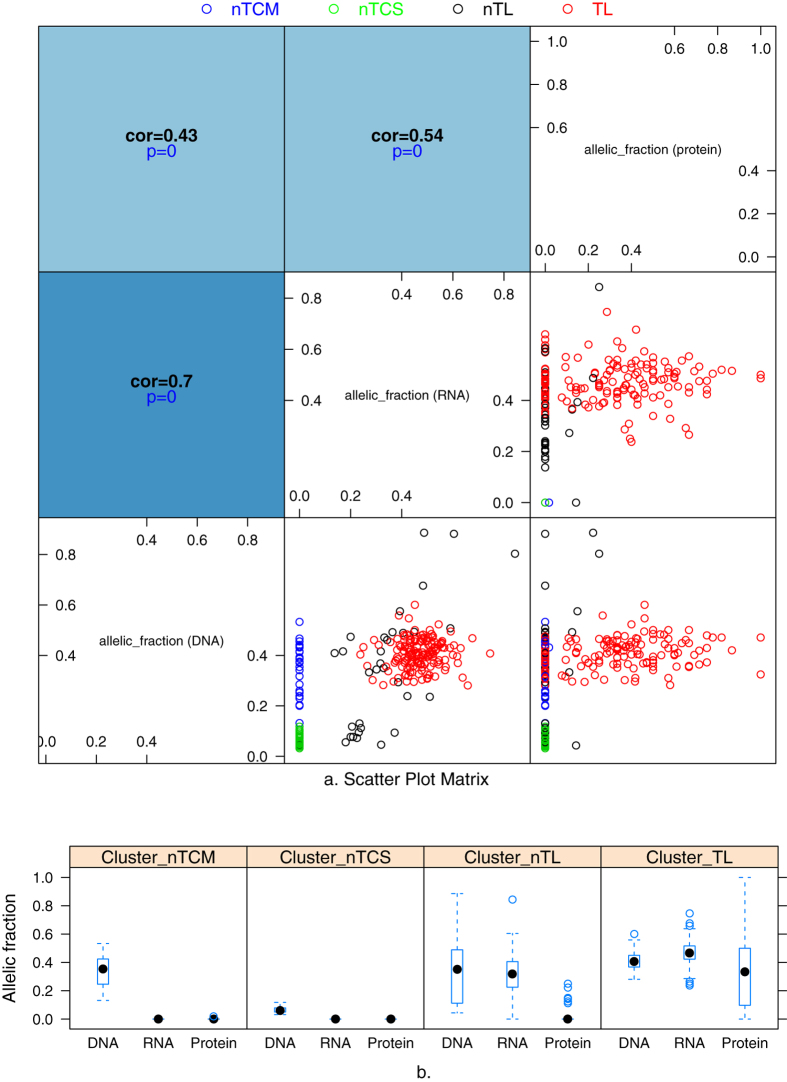
Expression patterns of somatic mutations at the transcriptome and proteome levels.(a) A scatter plot matrix indicated four categories of somatic mutations according to the allelic fraction. Different colors represent different clusters. Cluster_nTCM (blue), tumor-mutated alleles with a moderate allelic fraction that were not transcribed; Cluster_nTCS (green), tumor-mutated alleles with a small allelic fraction that were not transcribed; and Cluster_nTL (black), tumor-mutated alleles that were not translated; and Cluster_TL (red), tumor-mutated alleles that were translated. (b) Boxplot of allelic fractions at different levels according to clusters.